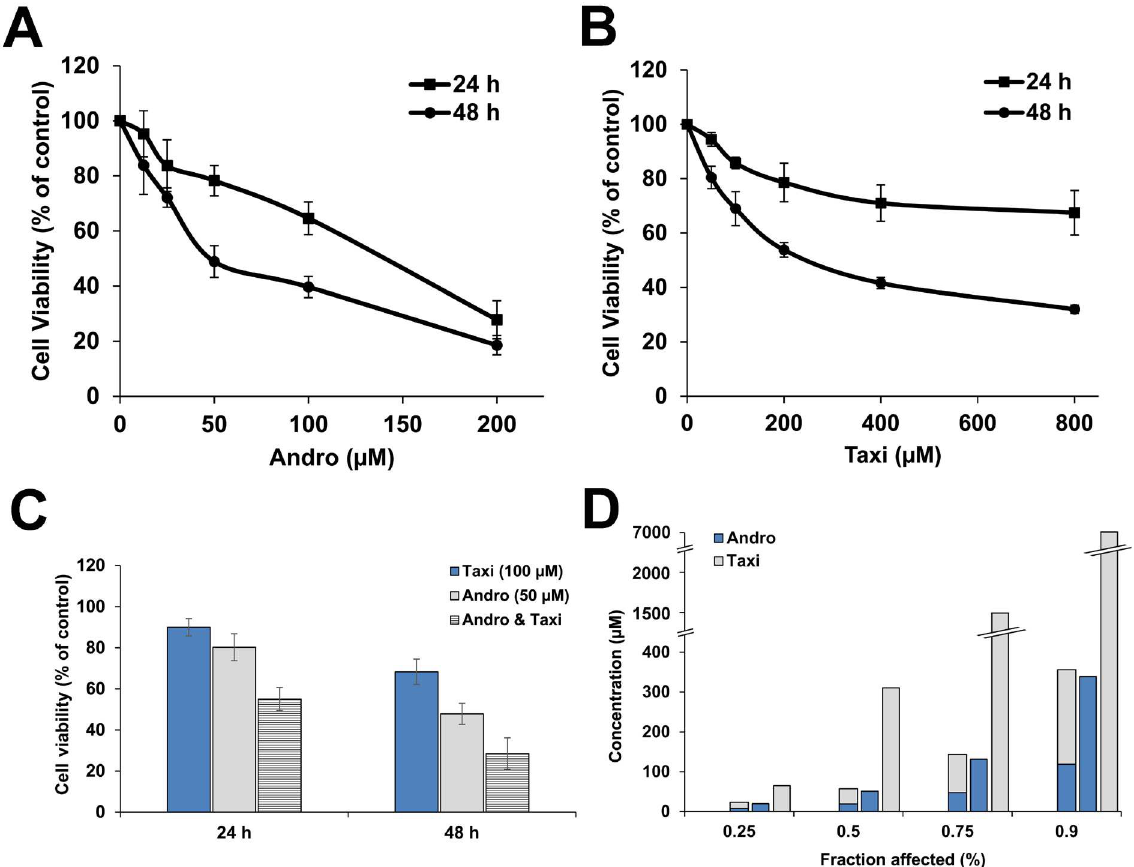
Fig 1. Effect of Andro and/or Taxi on the proliferation of HeLa cells. The cells were treated with different concentrations of Andro (A) or Taxi (B) alone or a combination of 50 μ M Andro and 100 μ M Taxi (C) for 24 or 48 h and then the cell viability was tested using the MTT assay. Values from each time point were then comparedto the control values and expressedas mean ± SD of three independentexperiments. (D) A graph representingthe decreasein the total concentration of Andro and Taxi when used in combination comparedto the single doses of Andro or